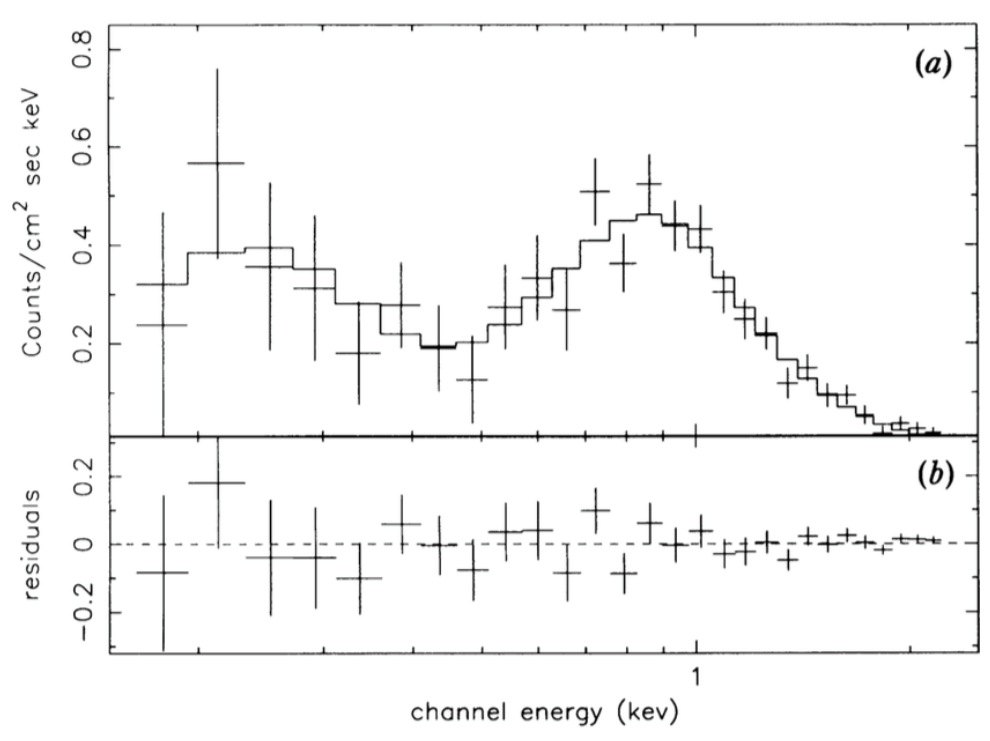
Figure 3. The ROSAT X-ray spectrum of the group NGC 2300 plotted together with the beat-fit Raymond-Smith model ( a ) and residuals from the best fit model ( b ). Figure reproduced with permission from Reference